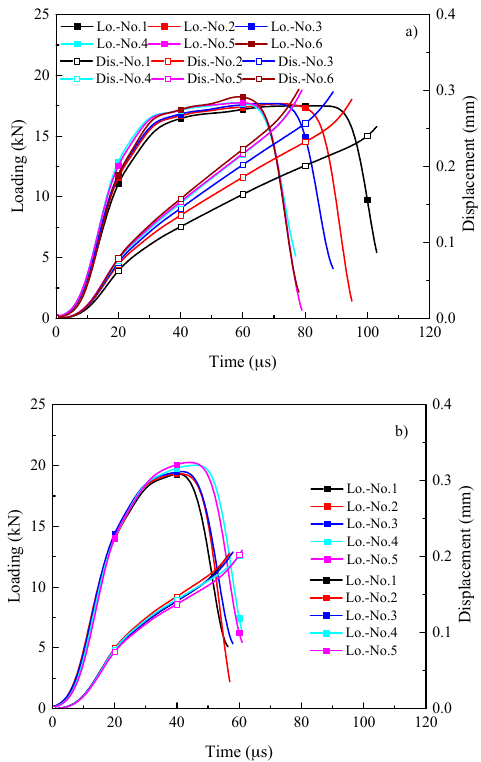
Figure 4. Loading and displacement vs. time for ( a ) Ti-64 alloy and ( b ) Ti-55511 alloy.